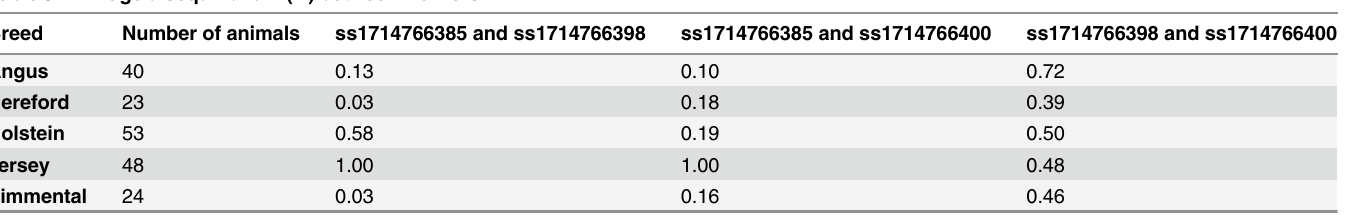
Table 5. Linkage disequilibrium (r 2 ) between markers. 1